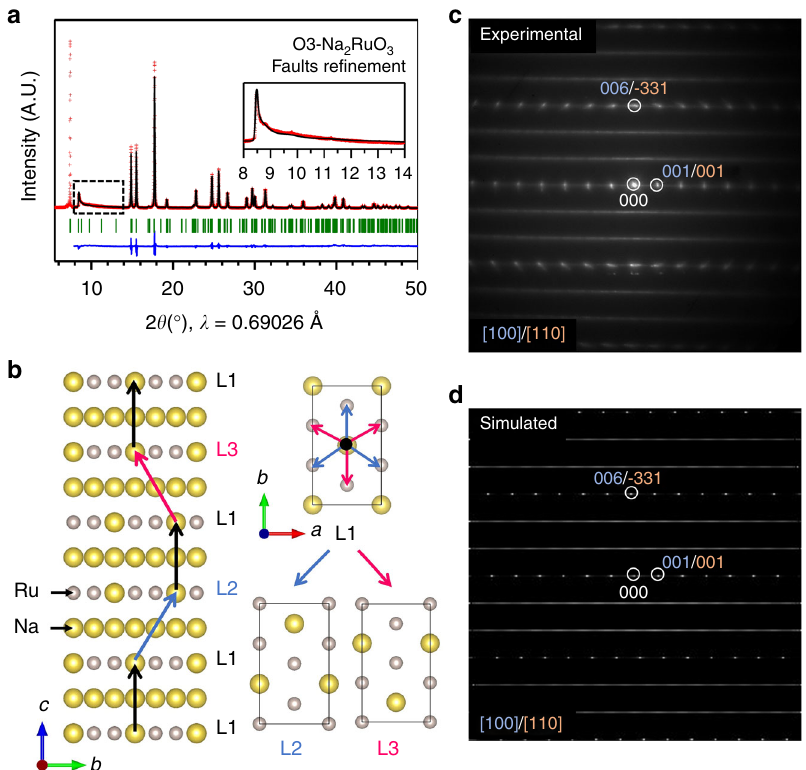
Fig. 1 Stacking faults in Na 2 RuO 3 . a Observed and calculated (FAULTS re fi nement) synchrotron XRD patterns of O3-Na 2 RuO 3 (pristine state). Observed data, the calculated pattern, and the difference between observed and calculated data are shown as plus sign (red), solid line (black) and continuous line (blue), respectively. The positions of Bragg re fl ections are indicated by vertical tick marks (green). The fi rst diffraction peak has been excluded from the re fi nement due to important asymmetry that FAULTS does not take into account. The insert is a zoom of the initial superstructure peaks (Warren fall). b Representation of the stacking faults in O3-Na 2 RuO 3 , using the FAULTS unit cell described in the text. c , d Experimental and simulated SAED pattern along the [100] ( = <[110] C 2/ m >) direction,